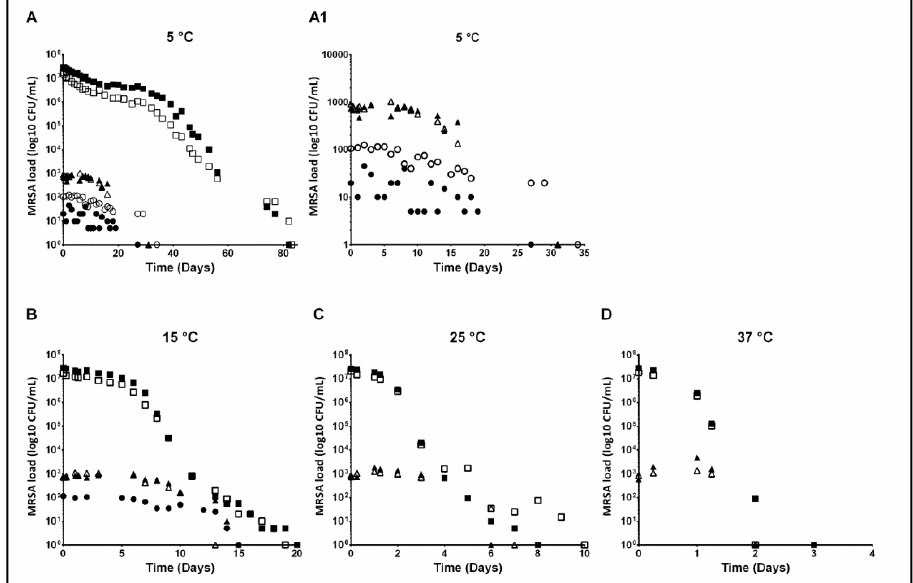
Figure 2. Survival curves of LA-MRSA in natural positive samples and spiked samples at four different temperatures; ( A ): 5 °C; ( A1 ): 5 °C, a close-up of low levels from ( A ); ( B ): 15 °C; ( C ): 25 °C; ( D ): 37 °C.